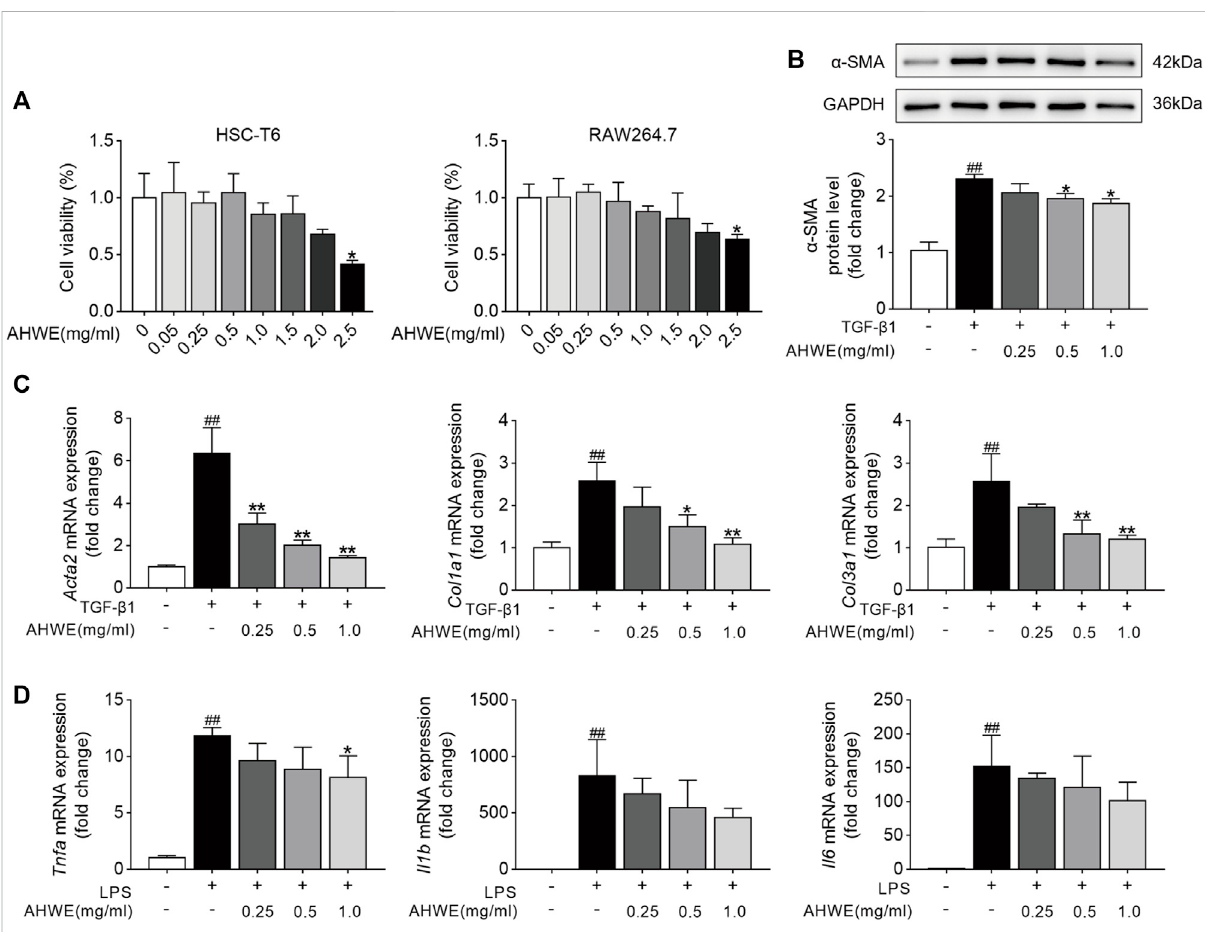
FIGURE 4 AHWE inhibited hepatic stellate cells activation and suppressed the in fl ammation in cell experiments. (A) The cytotoxicity of AHWE in the HSC- T6 cells and RAW 264.7 cells. Treatment with AHWE at different concentrations (0.005, 0.025,0.05,0.25,1.25, 2.5 mg/ml) for 24 h. Cell viability was detected by performing a CCK-8 assay ( n = 6). (B) The expression of the α -SMA was assessed by Western Blot ( n = 3). GAPDH was used as a loading control.Representativeimagesofthreeindependentexperimentsareshown. (C,D) ThemRNAexpressionofdifferent fi brosisandin fl ammatory factors withorwithoutinterferencewith AHWEinTGF- β 1-inducedHSC-T6cells( n =4) orRAW264.7 cellline.Data areexpressed asthemean±SD. # p < 0.05 and ## p < 0.01 vs. control group; p p < 0.05 and pp p < 0.01 vs. TGF- β 1 treatment or LPS